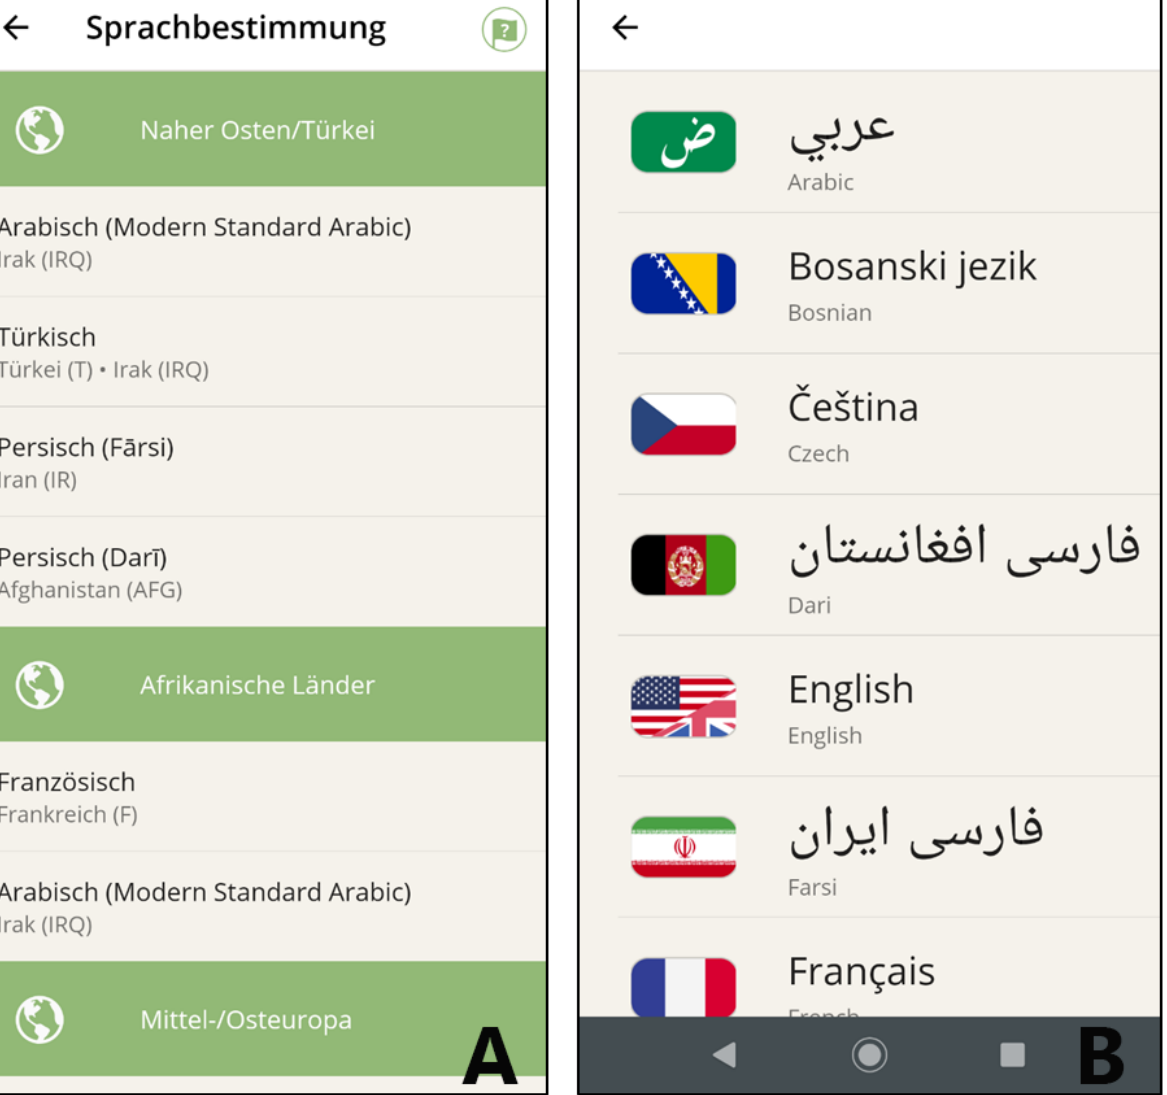
Figure 4. Paramedics select the language from (A) a geographically sorted directory or (B) have the patient choose from a flag button list that is sorted alphabetically and labeled in the original